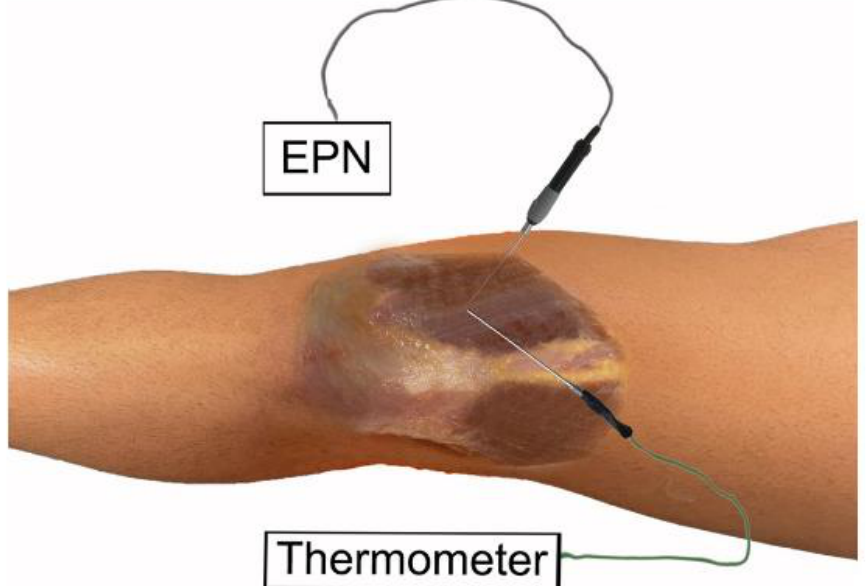
Figure 1. Percutaneous needle electrolysis on the vastus medialis on an anatomic sample.